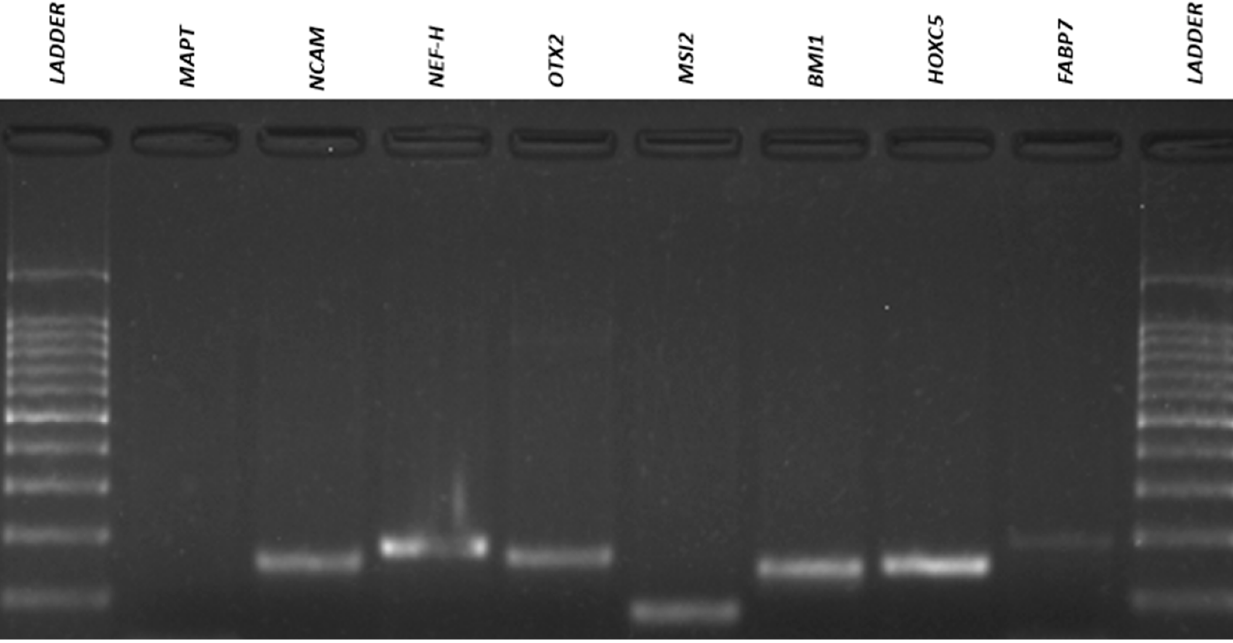
Figure 9. ADMSCs electrophoresis gel. RT-PCR for amplification of MAPT (218bp), NCAM (150bp), NEF-H (179bp), OTX2 (163bp), MSI2 (84bp), BMI1 (148bp), HOXC5 (149bp) and FABP7 (233bp) genes in ADMSCs. ADMSCs, adipose-derived mesenchymal stem cells.